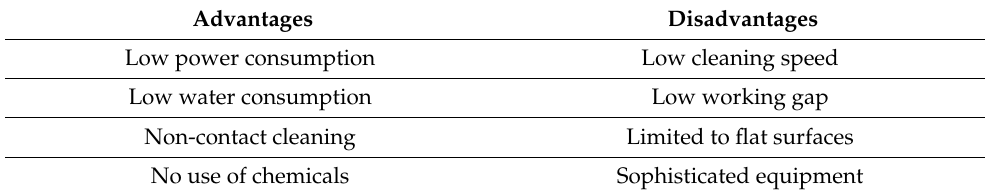
Figure 11. Boundary layer effect in pressurized waterjets. V is the flow speed. Table 10. The main advantages and disadvantages of non-immersion ultrasonic